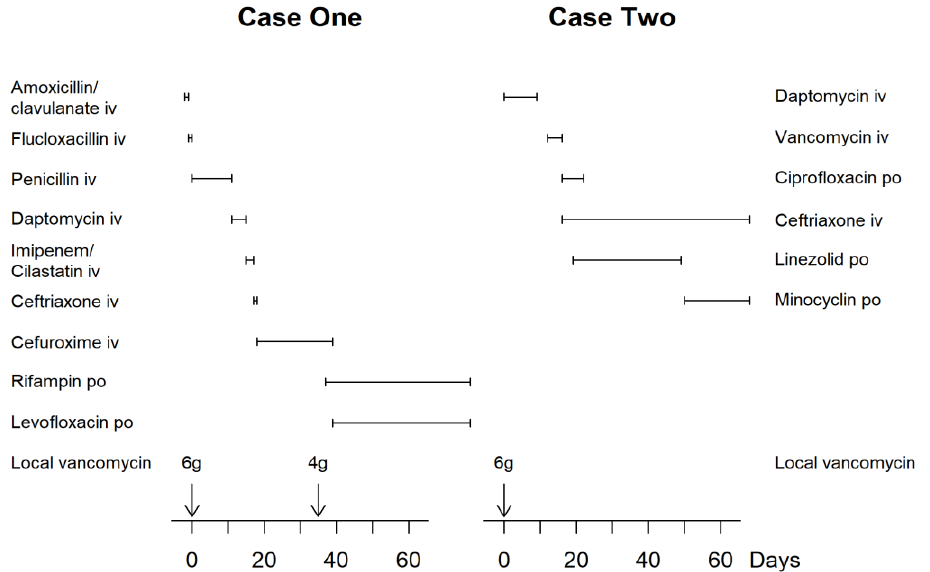
Figure 2. Summary of the systemic and local antibiotic therapy given over time in the two cases affected by symptomatic hypercalcaemia. Case One had developed interstitial nephritis secondary to administration of penicillin. Case Two had developed neurotoxicity as well as rhabdomyolysis secondary to administration of daptomycin. Both adverse reactions were entirely reversible.